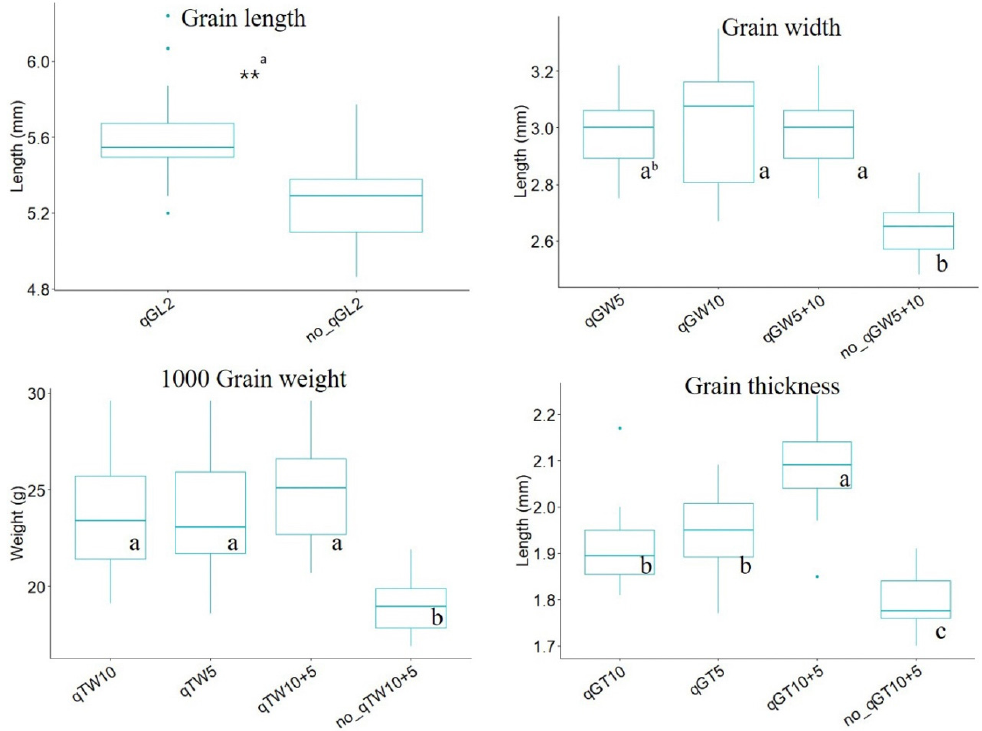
Figure 3. Effect of single QTL and QTL combinations on the following four traits: GL, GW, TGW, and GT. a Difference between the mean value of each line with qGL2 by t ‐ test. ** indicates significance at p < 0.01. b The letters (a, b, and c) showing difference within the mean values of QTL combination by Duncan multiple range test (DMRT) at a 5% significance